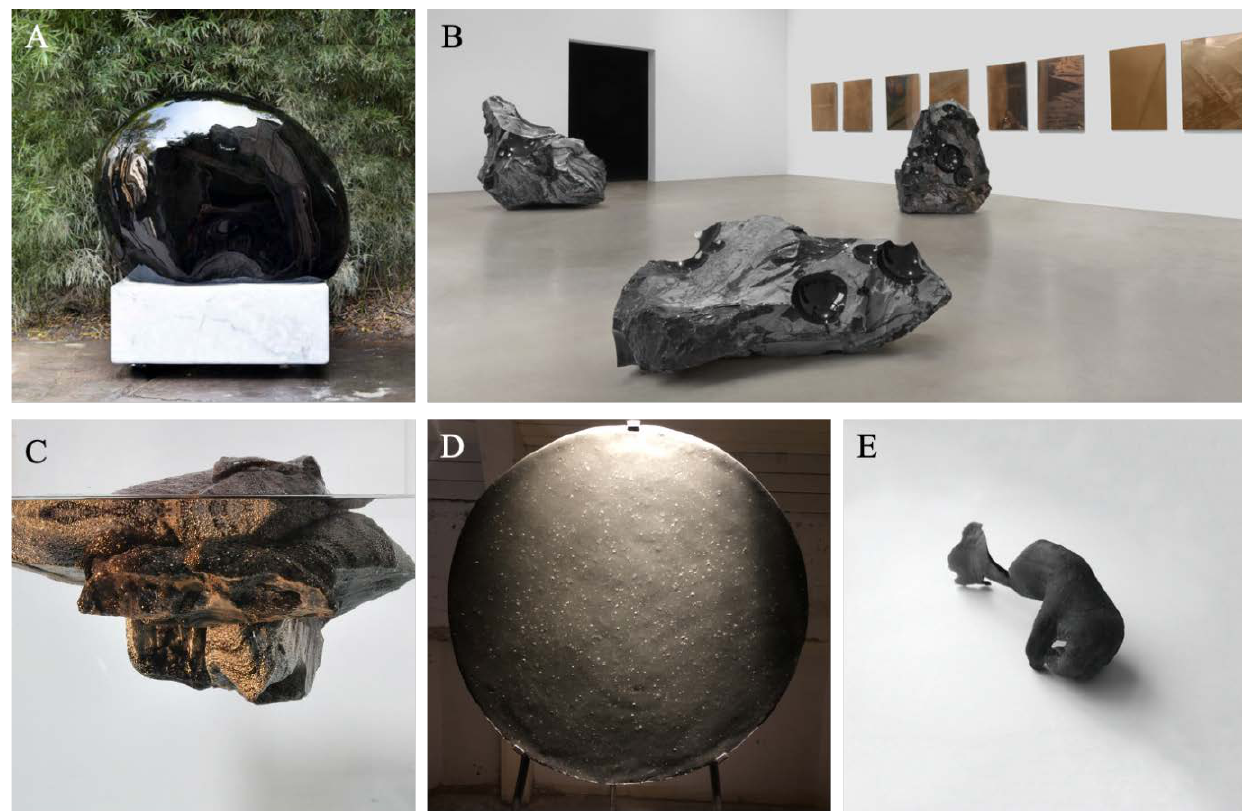
Figure 1: Examples of obsidian in modern glass art. [A] ‘Monolito’ by Eduardo Olbes; cold-worked, polished ob- sidian. [B] ‘Thickens, pools, flows, rushes, slows’ by Julian Charrière; cold-worked, partially polished obsidian (at Aargauer Kunsthaus, Aarau, Switzerland, 2020). [C] ‘Gravity’s Pull’ by Matt Durran; partially vesiculated obsidian. [D] Variation 1 of ‘Variations on an energetic field’ by Lucy Bleach; a thoroughly welded obsidian sheet. [E] ‘PEDM’ by Alastair Mackie; obsidian partially welded in a